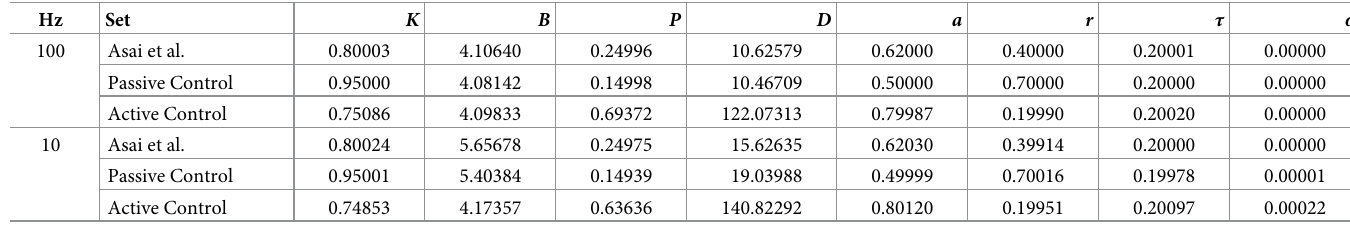
0.01s and again to every 0.1s. The noiseless series used in the first simulation are shown in Fig 1. Only one series per set and per downsample rate was used, as there were no sources of sam- pling error. To ensure that estimates converged to a high degree of precision, 3000 iterations of optimization were used. Table 4 contains the parameter estimates for these simulations, with sampling rate shown to the left. Only the velocity coefficients B and D exhibited substantial bias all throughout, and the “High Active” set incurred the greatest bias over nearly all parameters. Most parameter estimates given 100Hz sampling were exact to at least 3-5 decimal places. Reducing sampling resolution by a factor of ten increased biases to parameters B and D by a factor of ten to fifteen, but much less so for K and P . The nonlinear parameters a , r , and τ exhibited the least bias for all sets. Table 4. Parameter point estimates for simulated noiseless series. Downsampling rate in Hz is shown in the left column. See Table 3 for the true, data-generating param- eter values of each